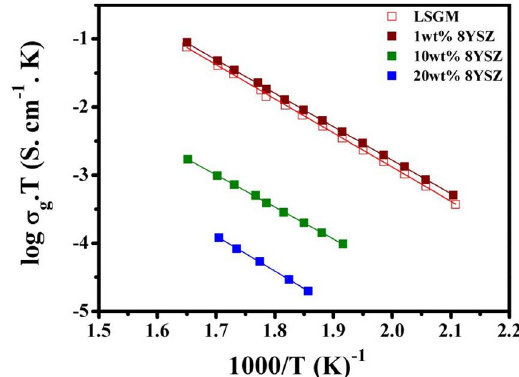
Figure 6. Arrhenius plots of the bulk conductivity of solid electrolytes sintered at 1450 ºC for 4 h.